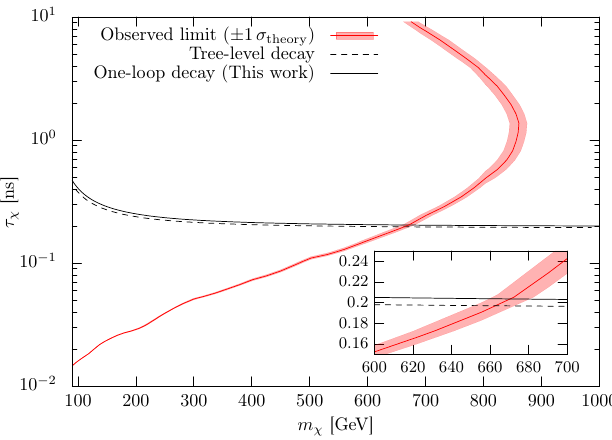
Figure 17 . The LHC constraint on the charged Wino mass and lifetime based on the disappearing charged track search. The red solid line shows the 95% CL limit by the ATLAS with data of R L dt = 136 fb − 1 and √ s = 13 TeV [29]. The red band shows ± 1 σ uncertainty of the production cross section of the Wino. The black solid line is the prediction with the two-loop mass difference and the one-loop decay rate, whereas the dashed line shows the result of the tree-level calculation.